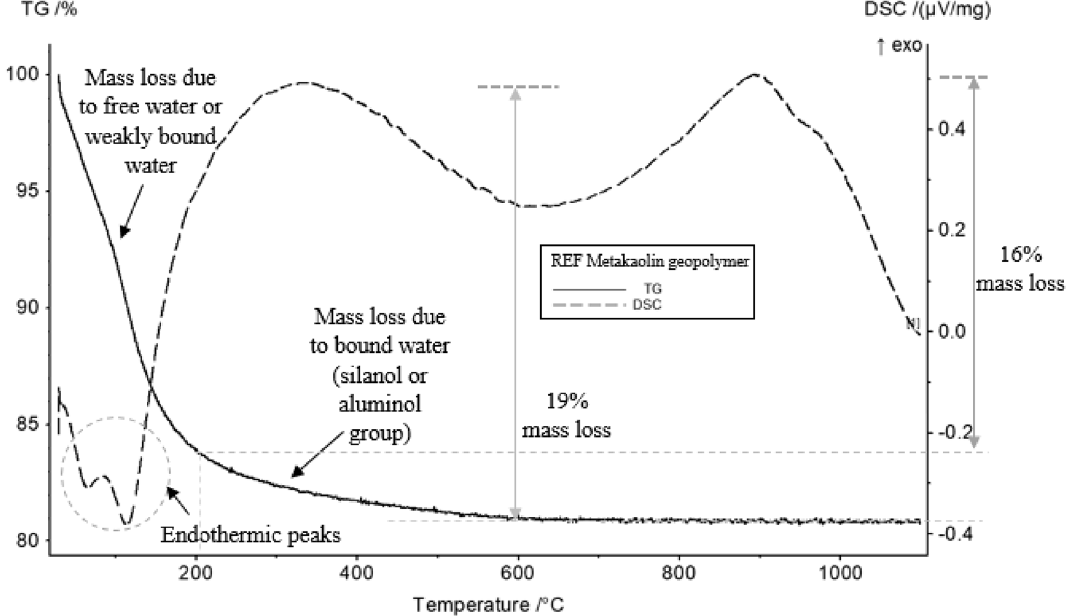
Fig. 7 TGA–DSC curve of REF metakaolin